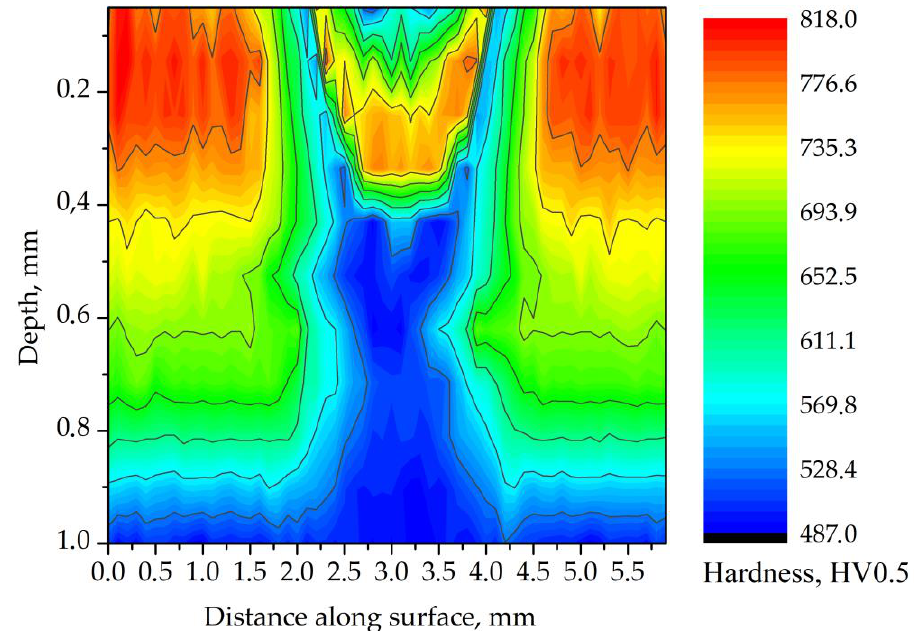
Figure 9. Hardness distribution for the cross-section of track 3. Processing parameters: laser beam power of 160 W, traverse speed of 500 mm·min −1 .